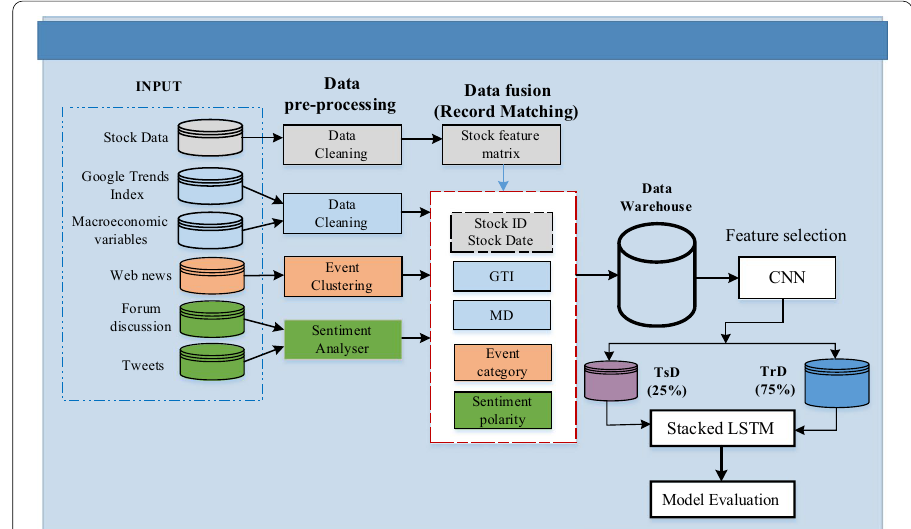
Fig. 1 Process flow of the proposed IKN-ConvLSTM framework